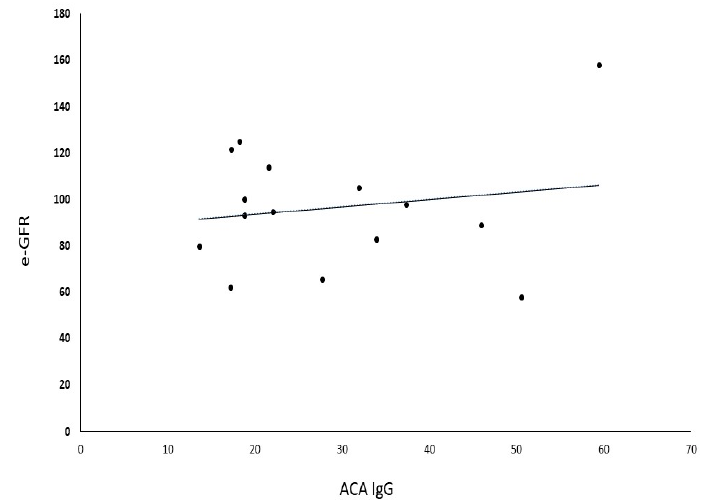
Figure 3. Correlation between e-GFR and ACA antibodies. e-GFR—estimated Glomerular Filtration Rate, ACA IgG—anticardiolipin antibodies type G.